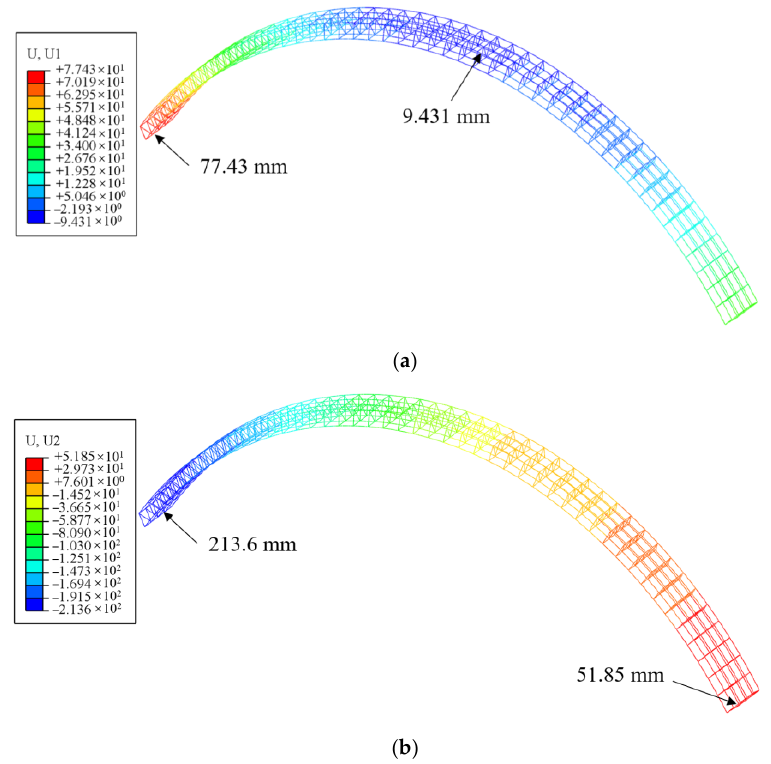
Figure 21. Deformation nephograms of the spatial reticulated grid. ( a ) Transverse deformation and ( b ) vertical deformation.